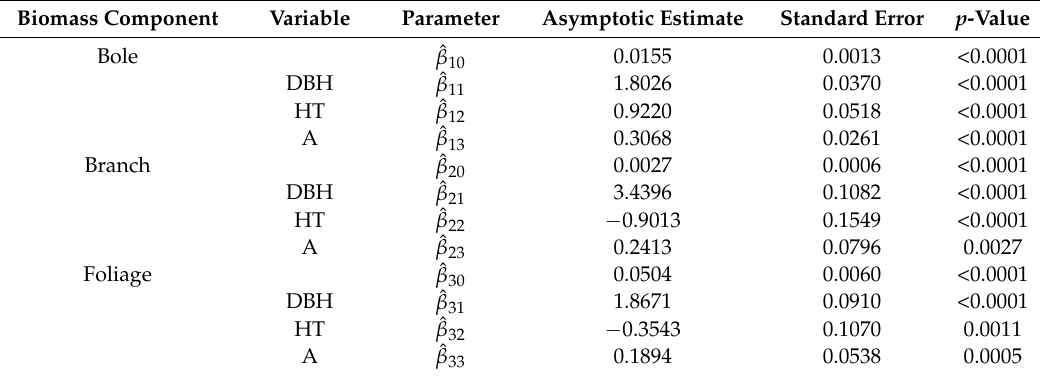
Table 6. Parameter estimates and their asymptotic standard error and p- values for the additive biomass equation system based on diameter at breast height (DBH), height (HT) and age (A) (Model System